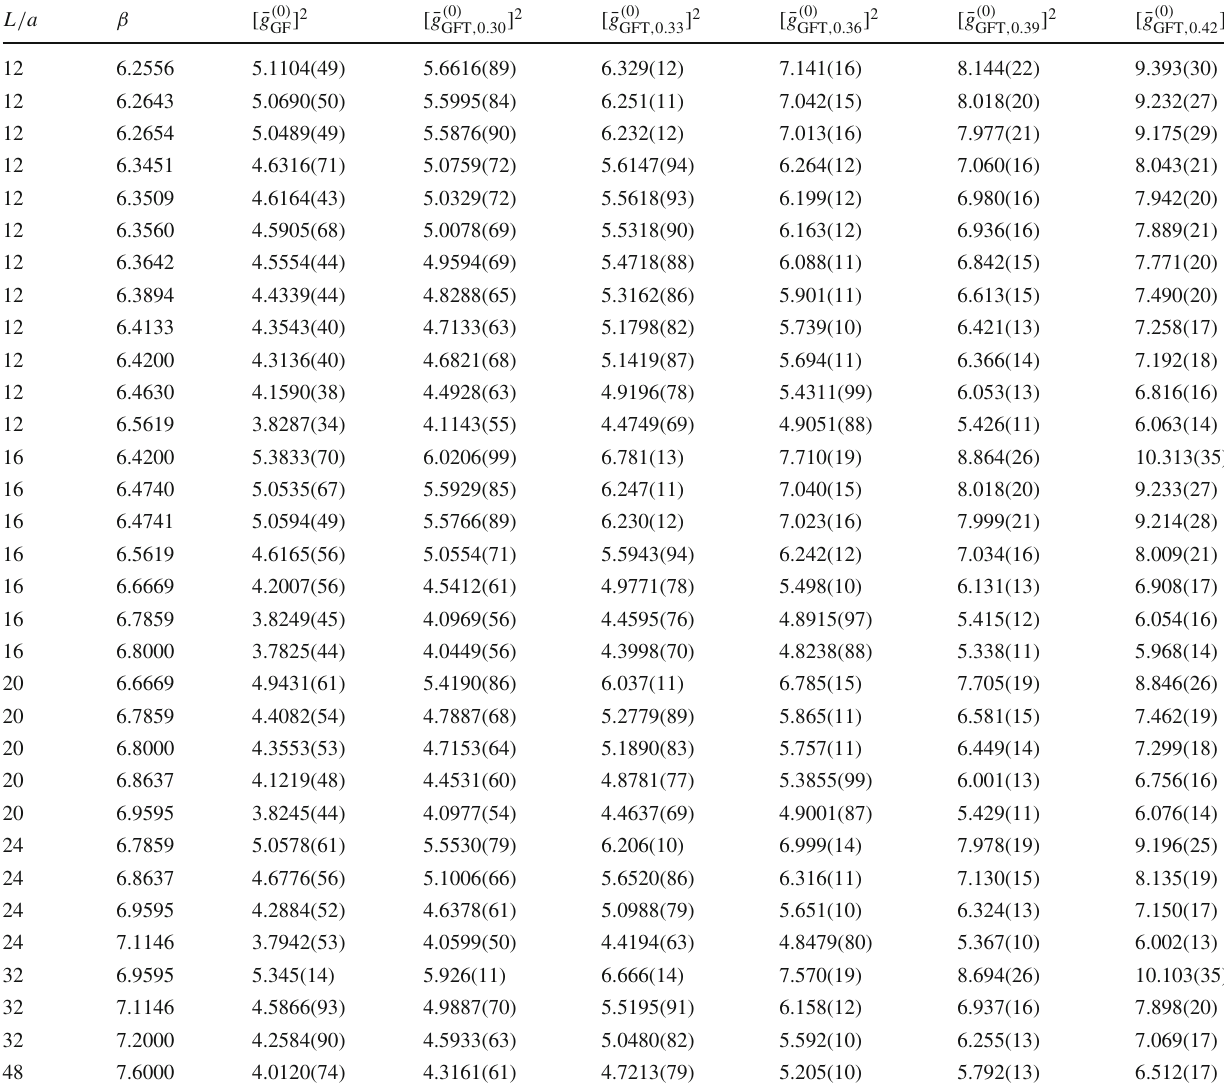
Table 9 Data used for the matching of the T = L and T = 2 L schemes L / a